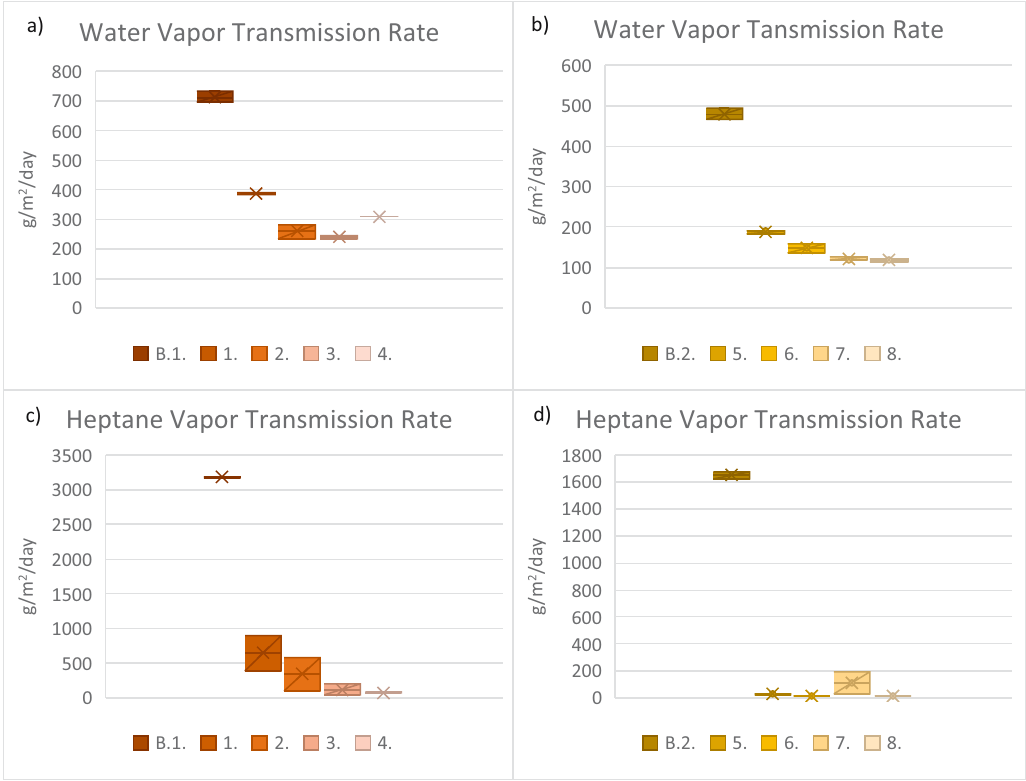
Figure 1: Results of the Water and Heptane Vapor Transmission Rate tests: ( a ) and ( c ) made on base paper 1, ( b ) and ( d ) made on base paper